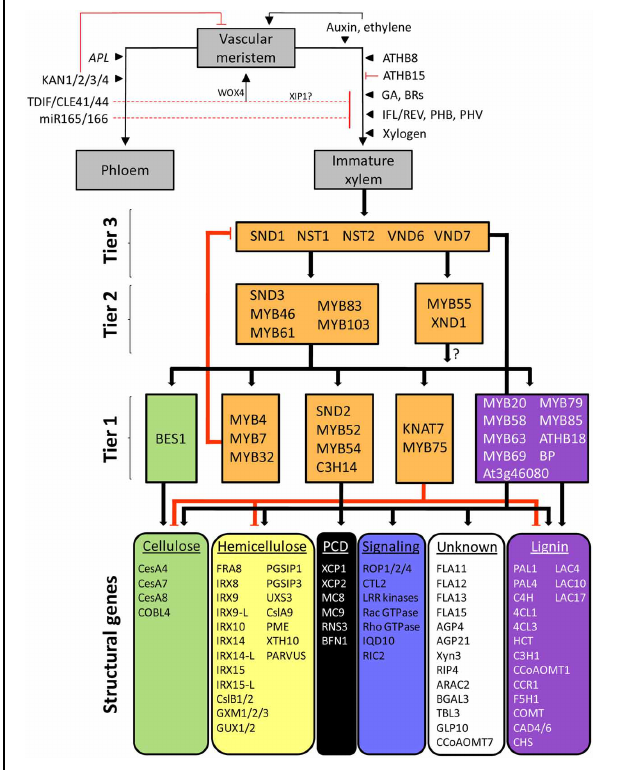
FIGURE 1 | The generalized Arabidopsis SCW transcriptional regulatory network in the light of vascular differentiation. Vascular meristems, representing procambiums or secondary cambiums, produce mother cells that differentiate into phloem and immature xylem tissue (gray boxes) under the influence of transcriptional, hormonal, peptide, and miRNA regulators. Terminal differentiation of immature xylem cells into vessel elements and fibers is regulated by a tiered transcriptional network regulating genes associated with secondary cell wall cellulose, hemicellulose, programmed cell death (PCD), signaling, lignin, and genes with unknown functions. Positive regulation is indicated by black arrows; negative regulation is represented by red edges. Block colors represent different biological function categories. TFs currently known to regulate only one functional category are color-matched accordingly; orange blocks denote regulation of a combination of functional categories. The same color scheme is used in Additional file 1